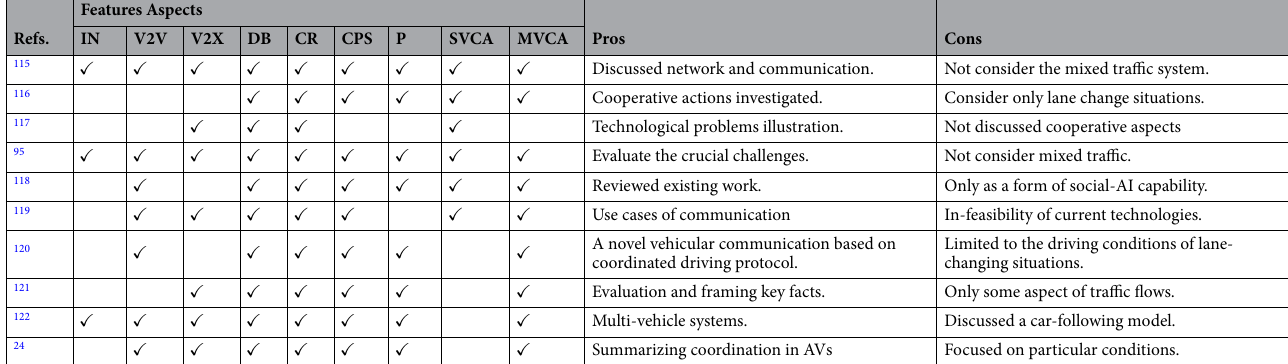
Table 5. Communication and cooperation for MVCCA in AVs. IN Intra-vehicle networking, V2V V2V communication, V2X V2X communication, DB Driving behavior, CR Coordination and reasoning, CPS Cooperative perception sharing, P Platooning, SVCA Single vehicle collision avoidance, MVCA Multiple vehicle collision avoidance.